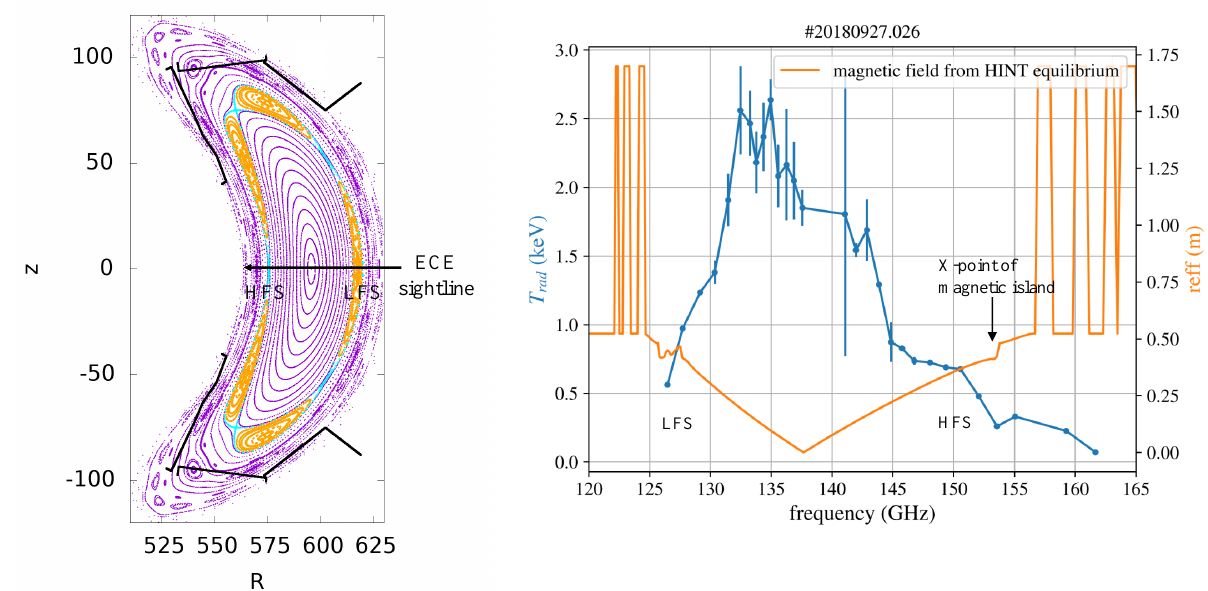
Figure 4: (a) Poincaré plot showing the magnetic flux surface for finite pressure with magnetic island chain (orange color) moved inside the last-closed-flux-surface. The sight line of ECE diagnostic crosses the island O-point on LFS passing the plasma center, and X-point on the HFS. (b) An ECE spectrum is shown where the pedestal can be seen around the channels from 150 to 155 GHz and the magnetic field calculated from the HINT equilibrium is shown as a function of e ff ective plasma radius. The location of the magnetic island is marked in the